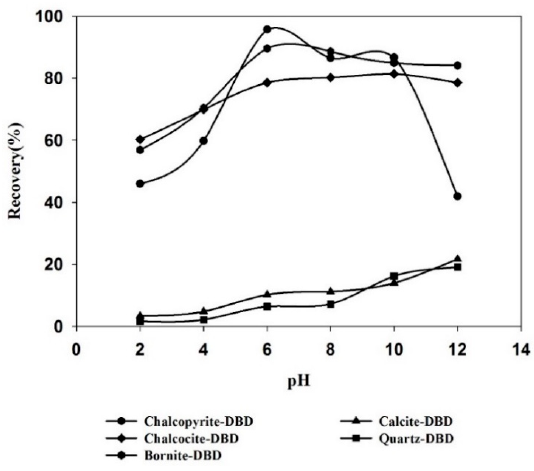
Figure 6. The zeta potentials of ( a ) chalcopyrite, ( b ) chalcocite, and ( c ) bornite as a function of pH in presence of collector mixture (SIBX:DBD).